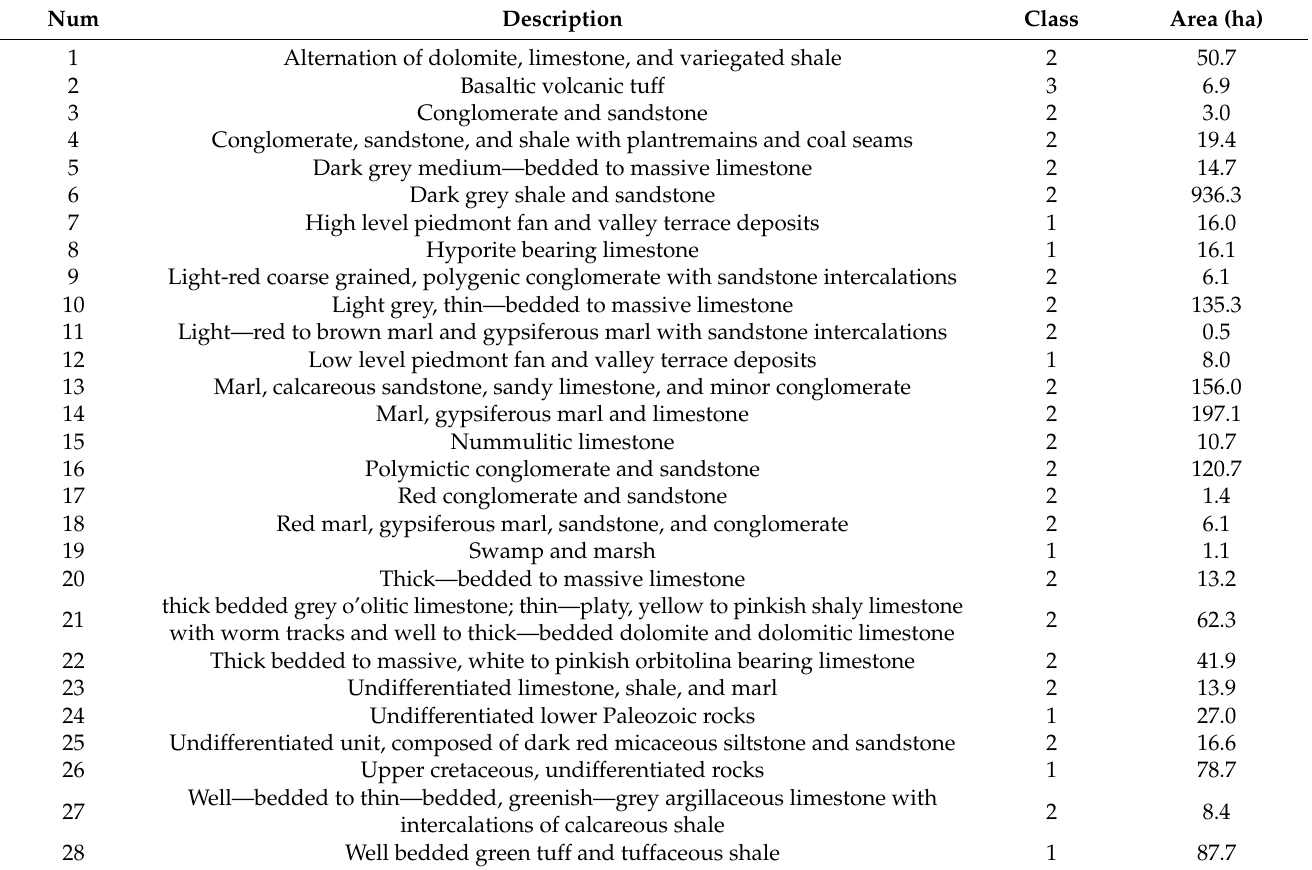
Table 4. The geolithological unites for study area of the Talar watershed and permeability